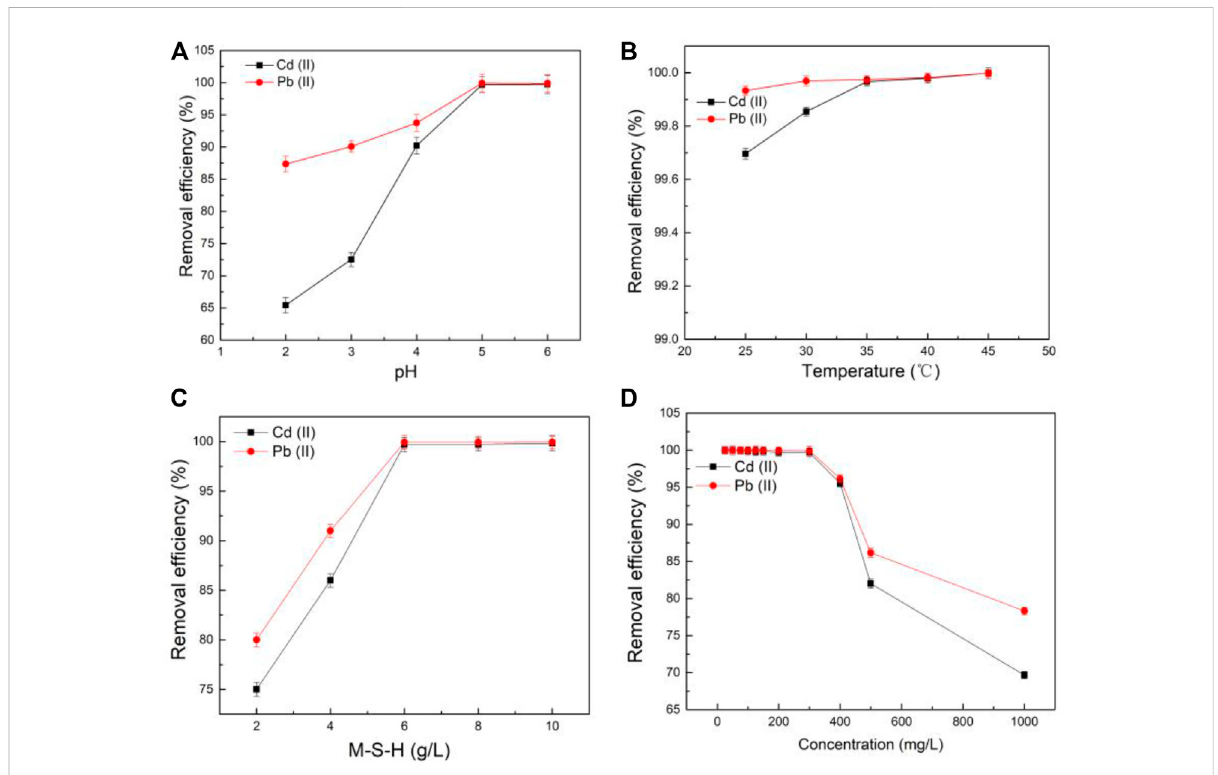
FIGURE 2 The effect of solution pH (A) , temperature (B) , M-S-H dosage (C) , and initial metals concentration (D) for adsorption ( (A) , 25 ° C [Cd(II)] 0 = [Pb (II)] 0 = 300 mg/L, reaction time 90 min, 6 g/L M-S-H; (B) , pH 5 [Cd(II)] 0 = [Pb (II)] 0 = 300 mg/L, 90 min, 6 g/L M-S-H; (C) , 25 ° C, pH 5 [Cd(II)] 0 = [Pb (II)]